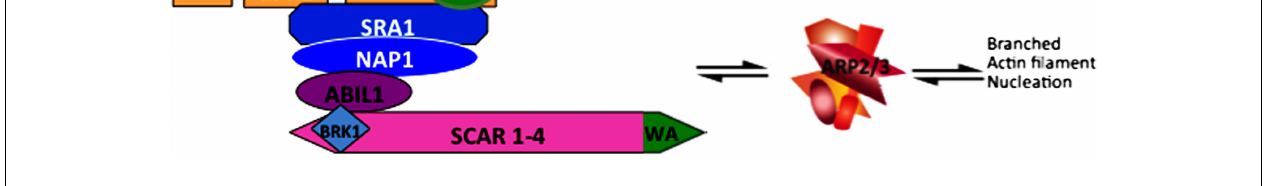
physically interacts with and activates ARP2/3.The output of the pathway is the generation of branched actin filaments in which ARP2/3 binds to the side of a mother filament and nucleates a new